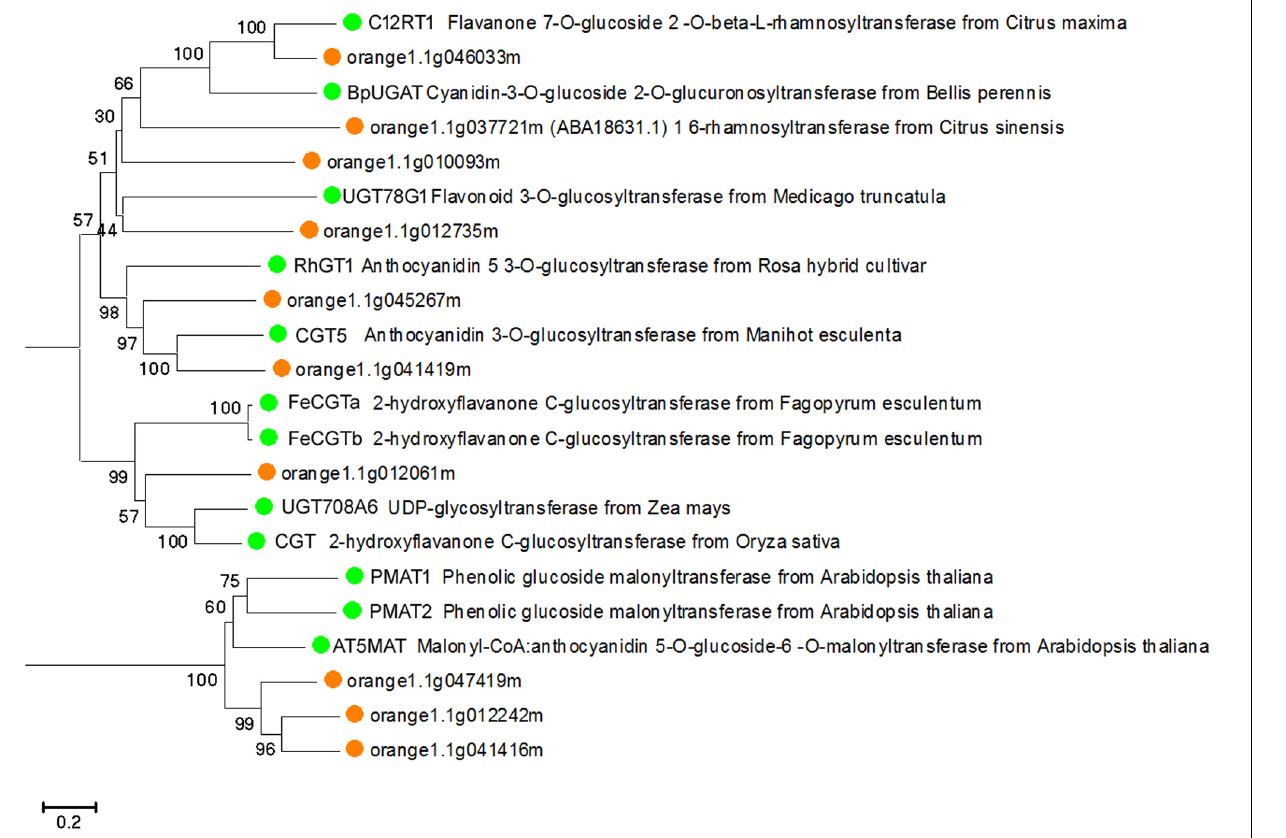
Frontiers in Plant Science |